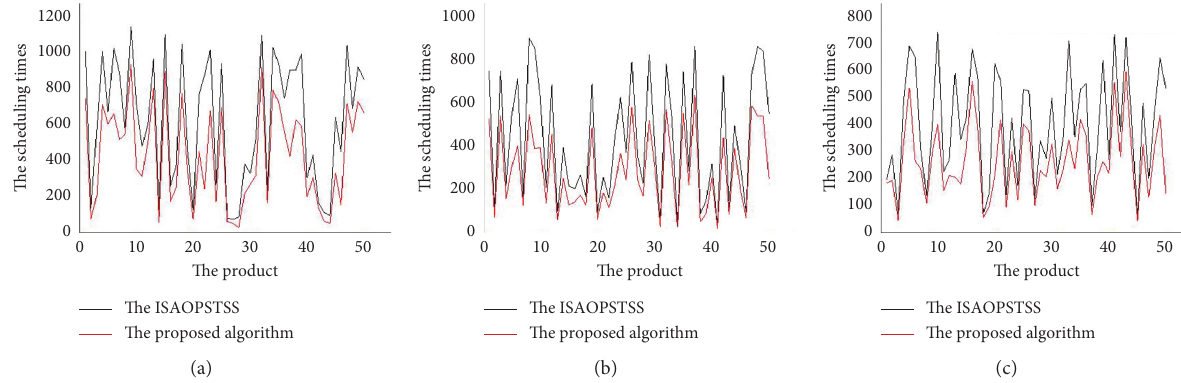
Figure 6: Comparison of scheduling times when the total number of processes is 50. (a) The scheduling times of 50 processes in 3 devices. (b) The scheduling times of 50 processes in 6 devices. (c) The scheduling times of 50 processes in 9